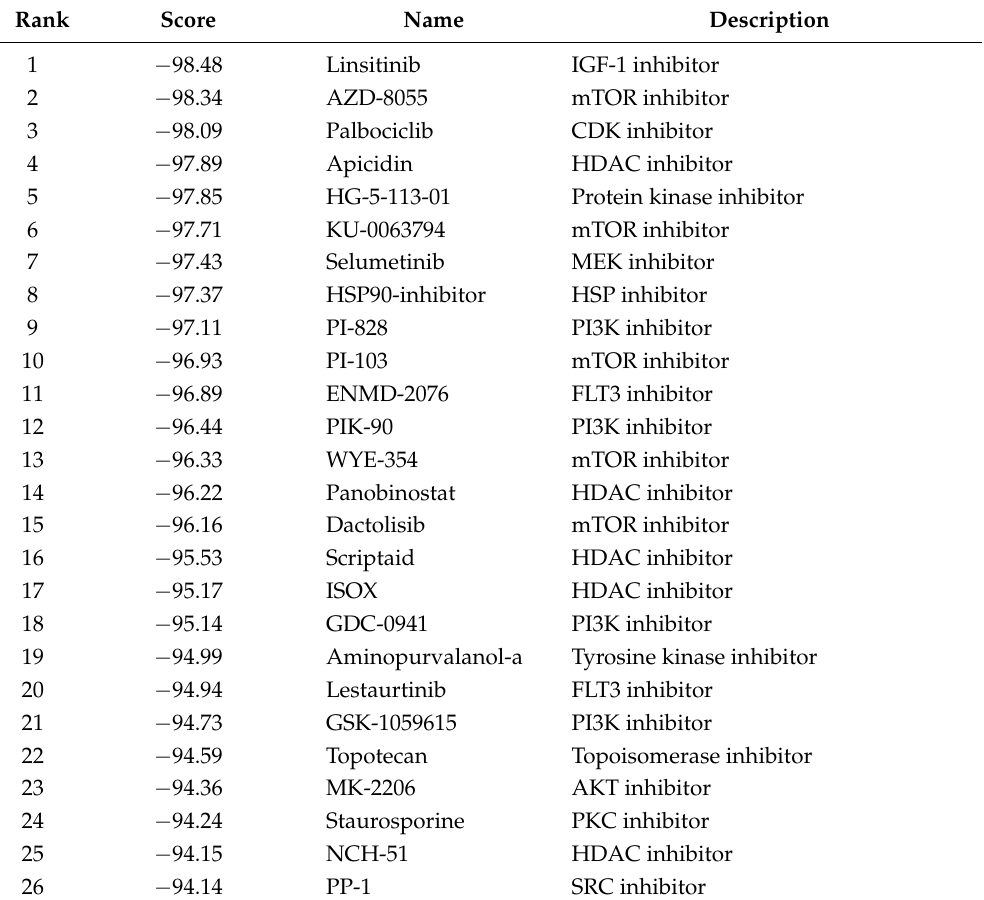
Table 1. Perturbagens with connectivity score of less than −